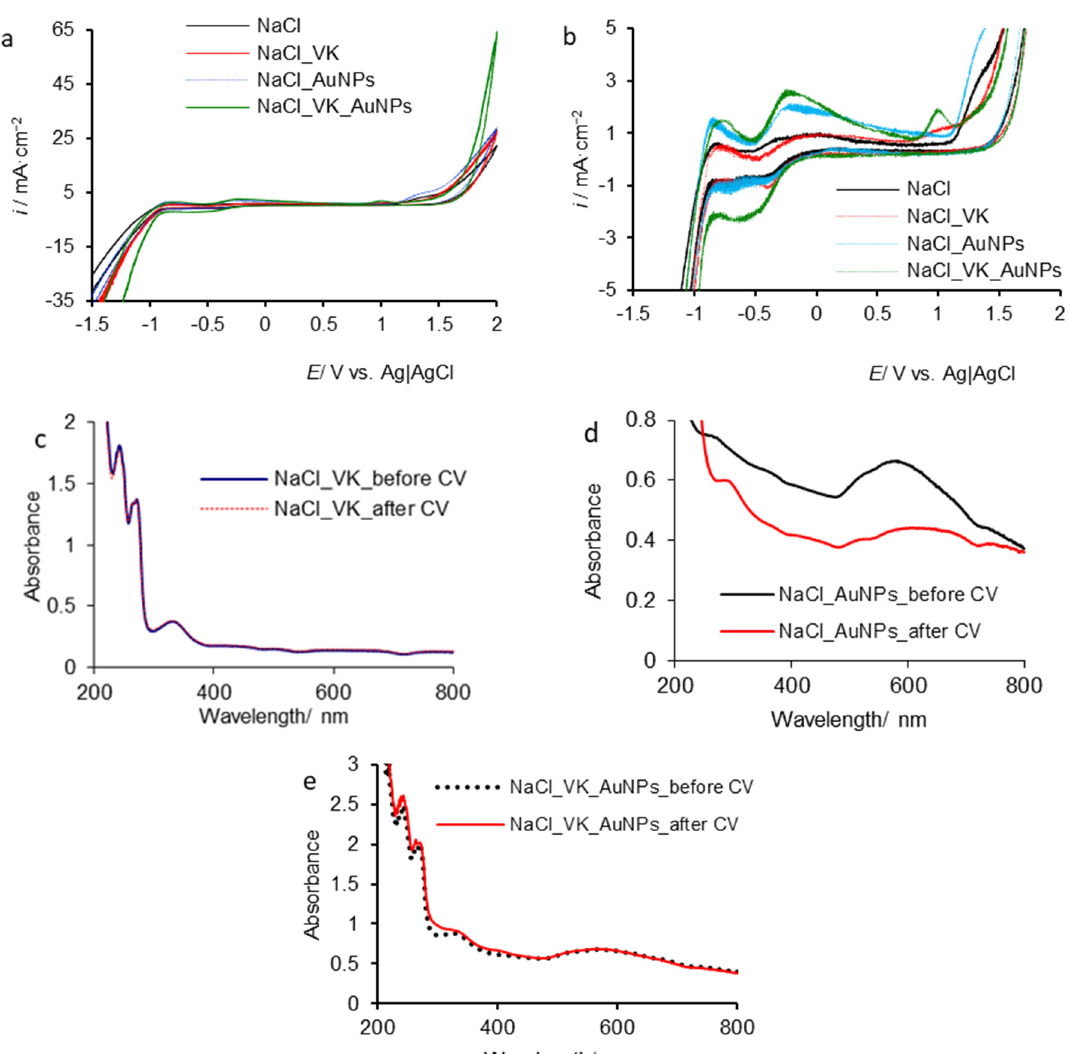
Figure 4. Cyclic voltammograms recorded on platinum electrode in 0.1 mol·L − 1 NaCl blank solution and 0.1 mol·L − 1 NaCl solution containing 6.65 × 10 − 5 mol·L − 1 VK, in the absence and presence of 75 mg·L − 1 AuNPs ( a ) and their details for low current densities ( b ); UV-Vis spectra collected before and after CV; ( c )—in NaCl solution containing VK (NaCl–VK); ( d )—in NaCl solution containing AuNPs (NaCl–AuNPs); ( e )—in NaCl solution containing VK and AuNPs (NaCl–VK–AuNPs).